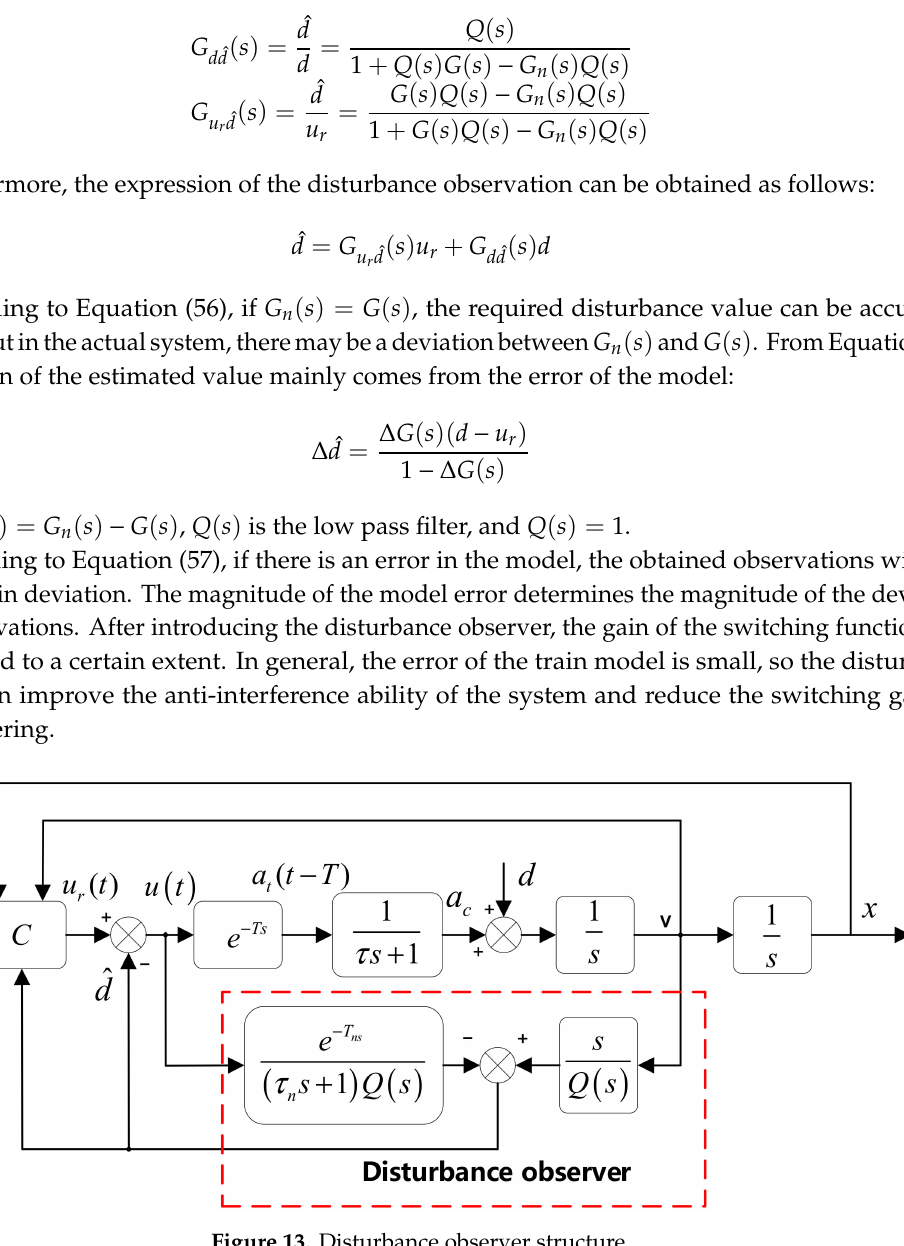
Figure 13. Disturbance observer